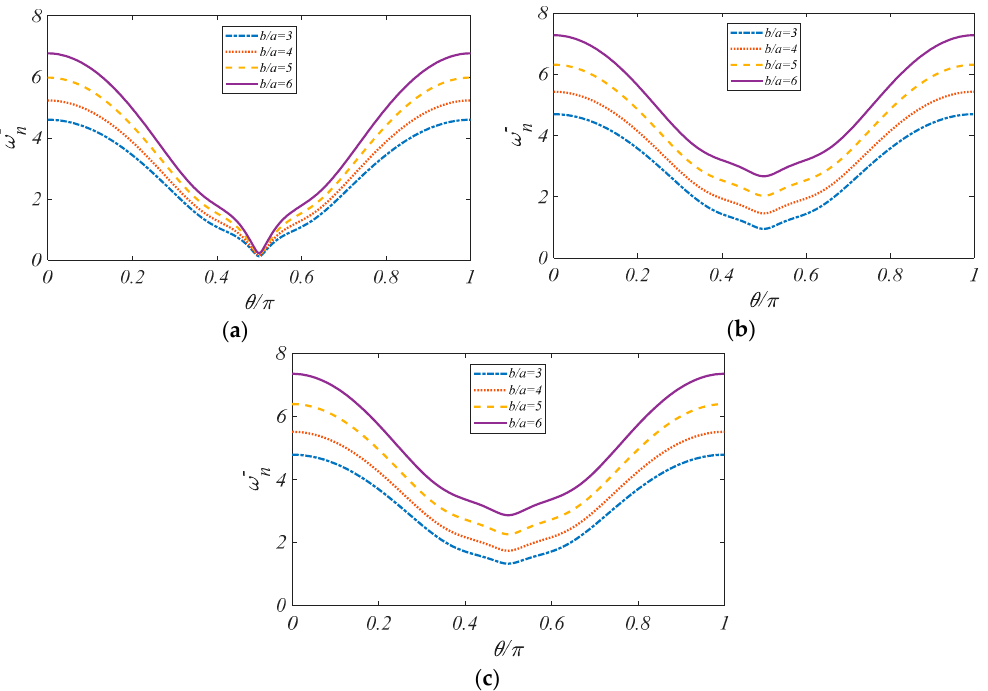
MHCAP with clamp-clamp boundary conditions for different orientation angles of carbon fibers and b/a = 4, h/b = 0.1, STR, T i = 273 [K], T o = 300 [K], V F = 0.2, FG-A, β = 1, K p = 10 [MN/m], and K w = 100 [MN/m 3 ].